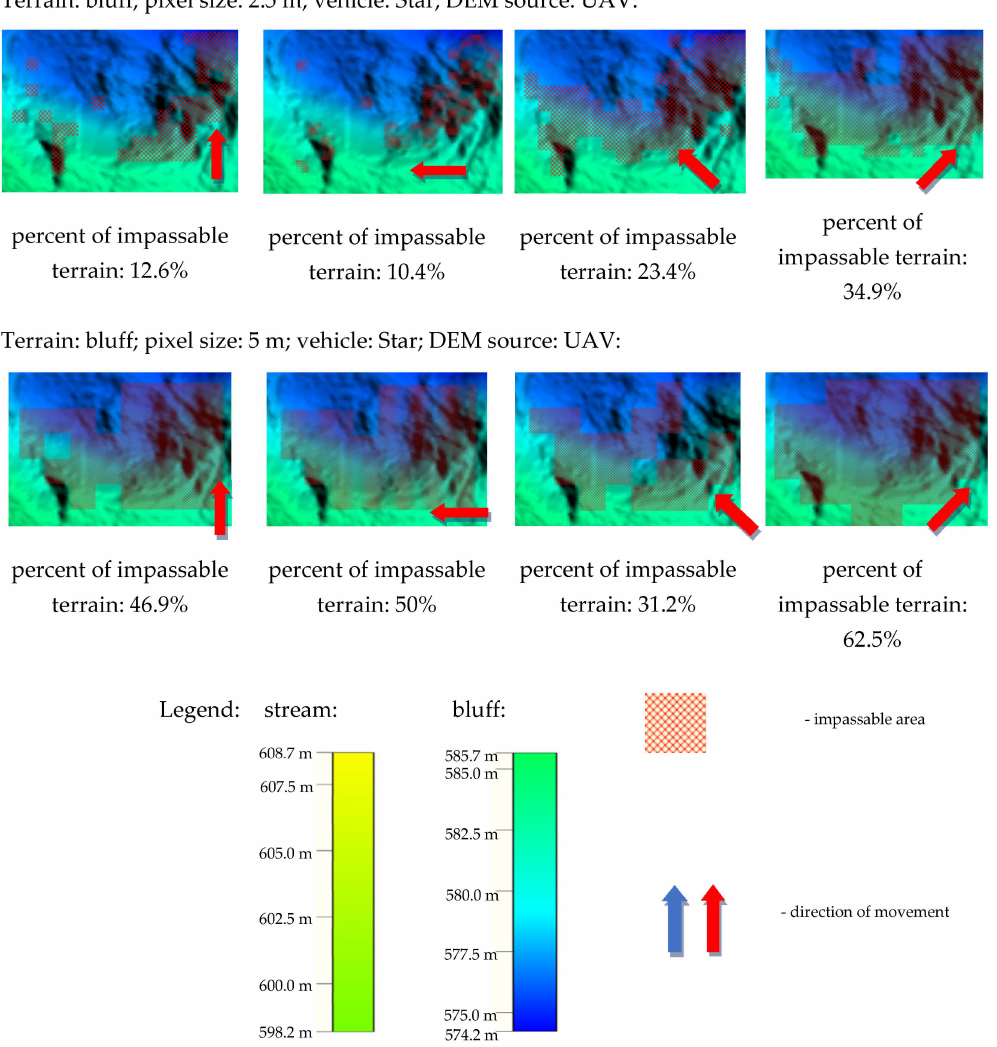
Figure 11. Results of the analysis.